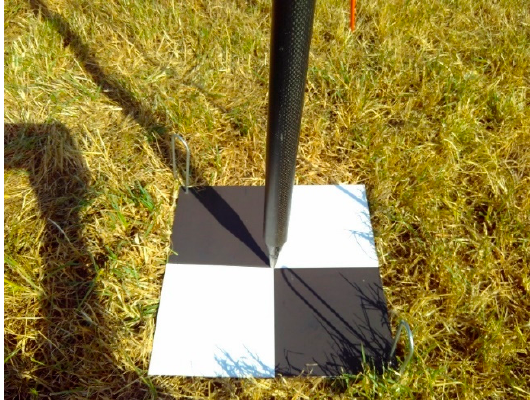
Figure 4. Measurement of reference points.